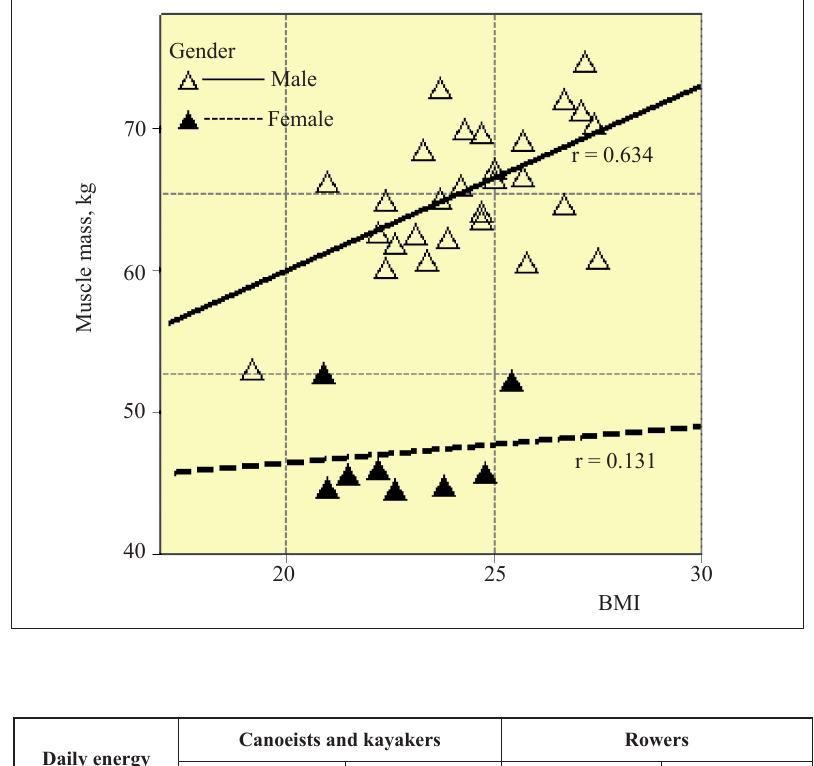
Figure 1. Correlation of BMI with muscle mass (by gender)